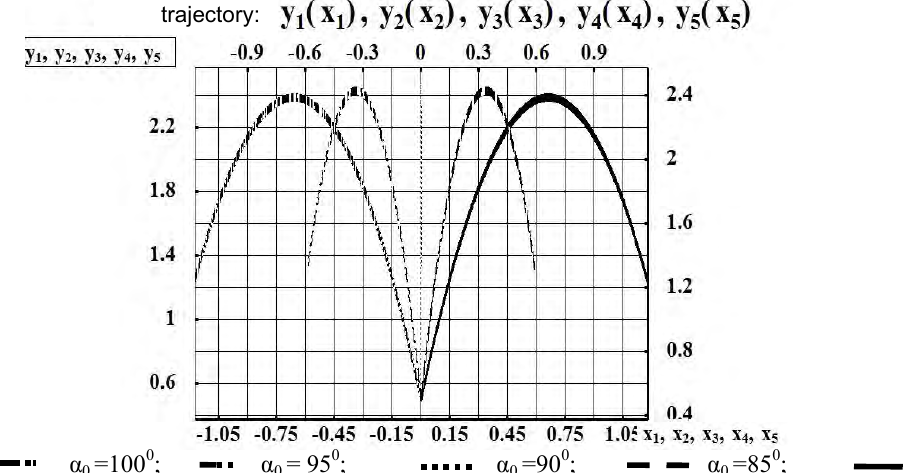
Fig.3. Characteristic curves of body masses center’s trajectory for different values of initial rush out speed.